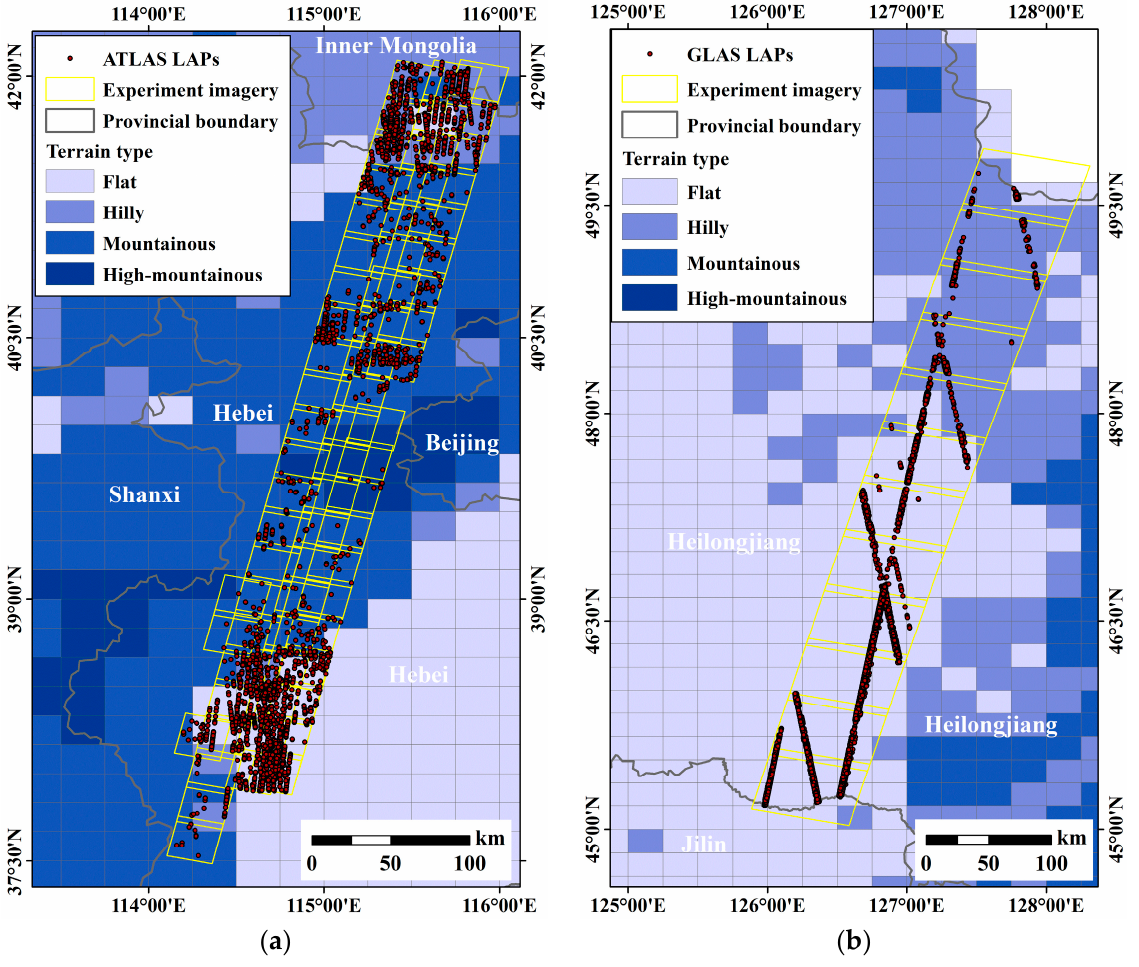
Figure 7. Geographical distributions of the ATLAS and GLAS LAPs: ( a ) ATLAS LAPs, ( b ) GLAS LAPs.